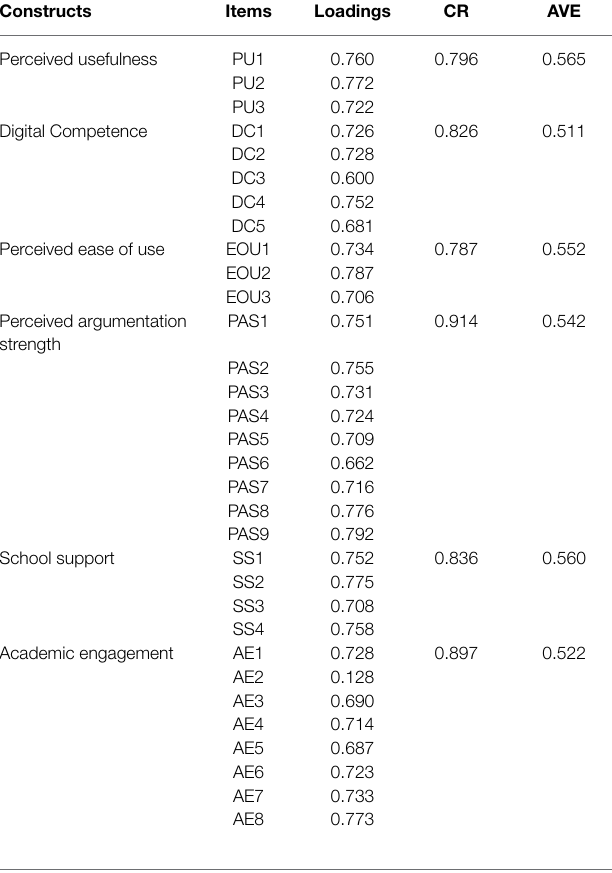
TABLE 1 | Factor loadings, composite reliability, and average variance extracted.